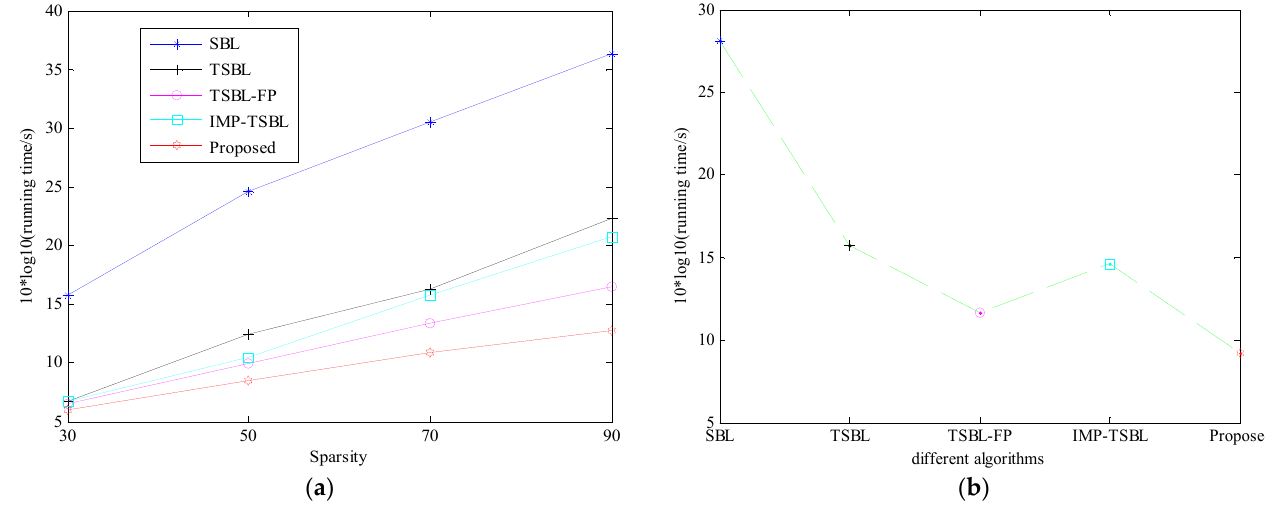
Figure 3. Running time comparison of five different methods in the sparse solution calculation: ( a ) Comparison with different sparsity, ( b ) Comparison when sparsity is 60